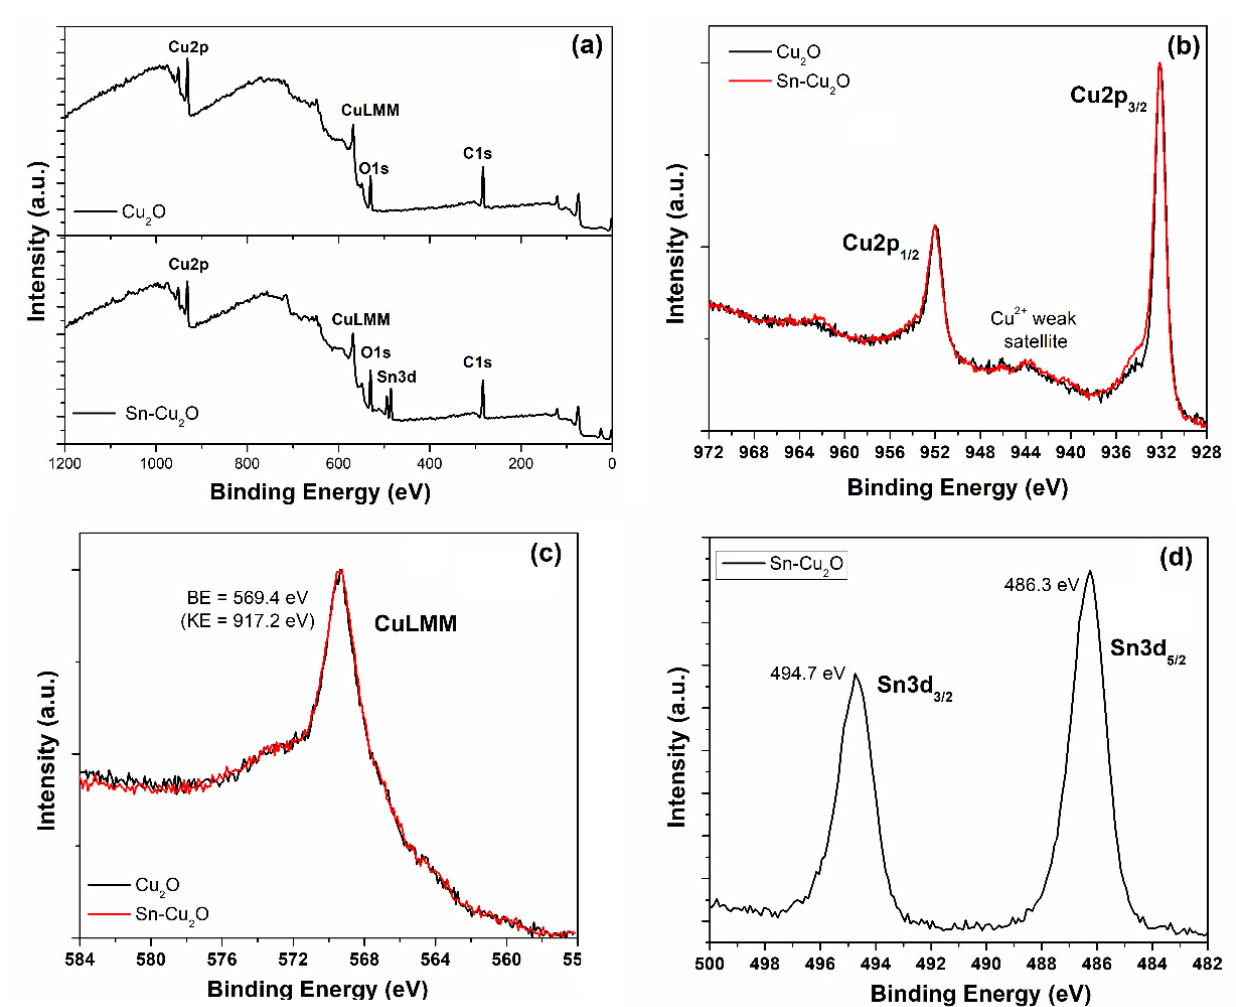
Figure 3. XPS analyses on the prepared samples: ( a ) survey spectra, ( b ) Cu2p doublet HR spectra, ( c ) CuL 3 M 4.5 M 4.5 Auger peaks, and ( d ) Sn3d doublet HR spectrum.